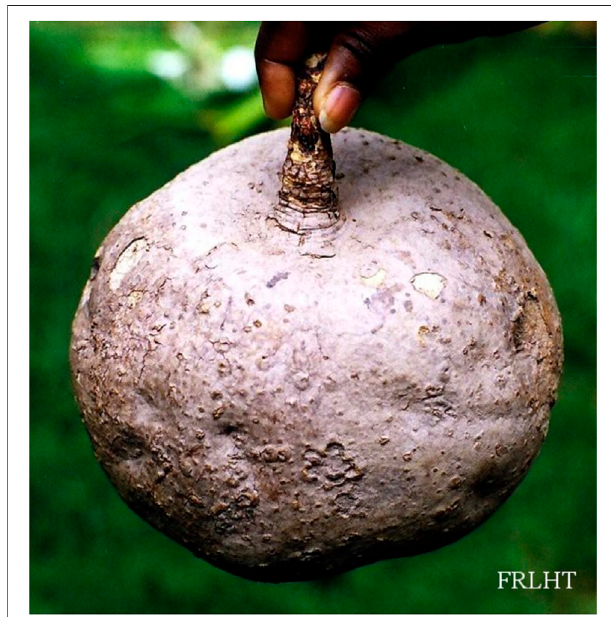
FIGURE 2 | Indian Medicinal Plant database.